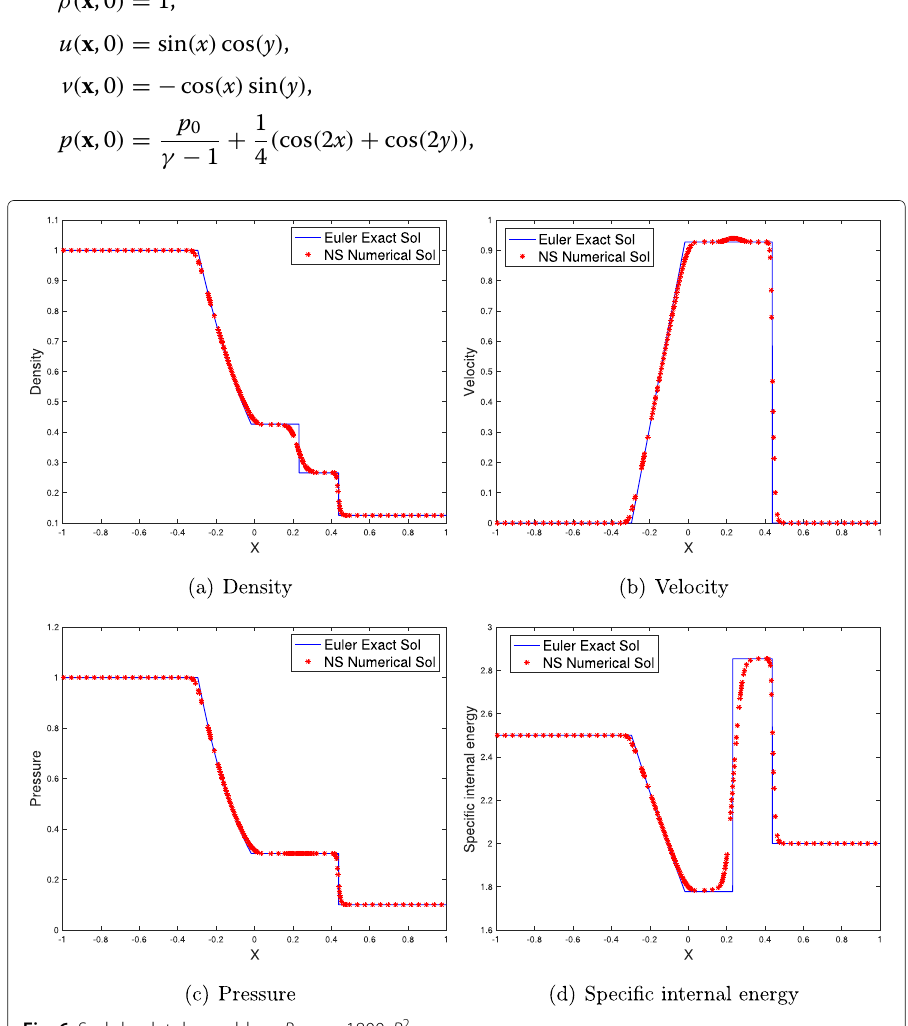
Fig. 6 Sod shock-tube problem, Re ∞ = 1800, P